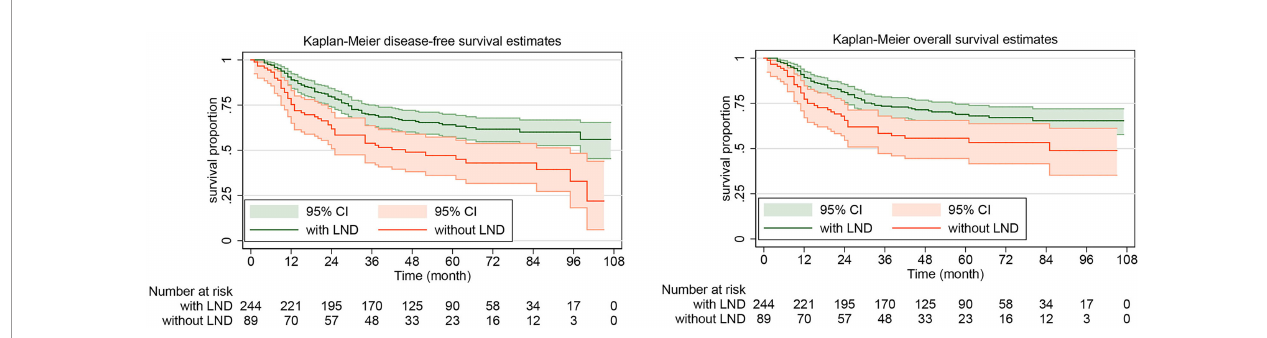
FIGURE 2 | Kaplan-Meier curves of disease-free survival and overall survival for patients with apparent early-stage clear cell carcinoma of the endometrium, by whether or not systematic lymphadenectomy was performed. LND, lymph node dissection.